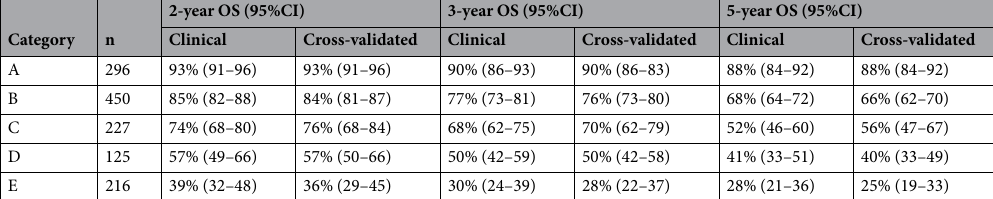
Table 4. Overall survival at 2, 3 and 5 years for clinical and cross-validated categories. Detailed comparison of overall survival (OS) with corresponding 95% confidence interval (CI) in each of the clinical and cross- validated risk categories at 2, 3 and 5 years (n =